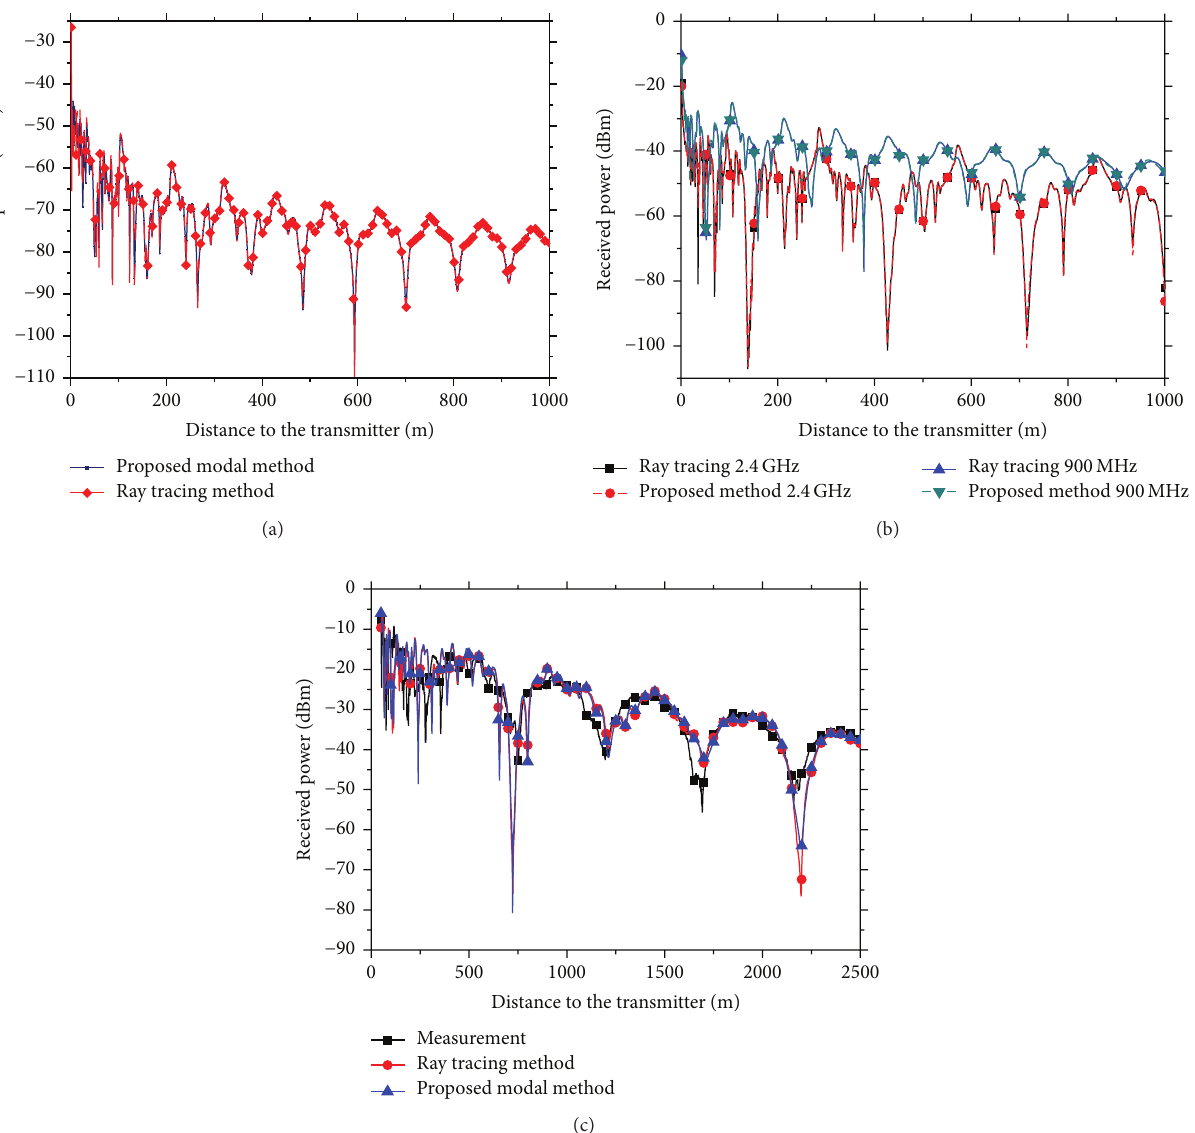
Figure 2: Comparison of the received power curves obtained by different methods with measurement of (a) the azimuth and elevation angles of antenna beam are 30 ∘ , and beam width is 15 ∘ ; (b) comparison of the received power obtained by the proposed modal method with the measurement result in the Massif Central tunnel [20]; and (c) comparison of the received power at different frequencies obtained by the proposed method and ray tracing